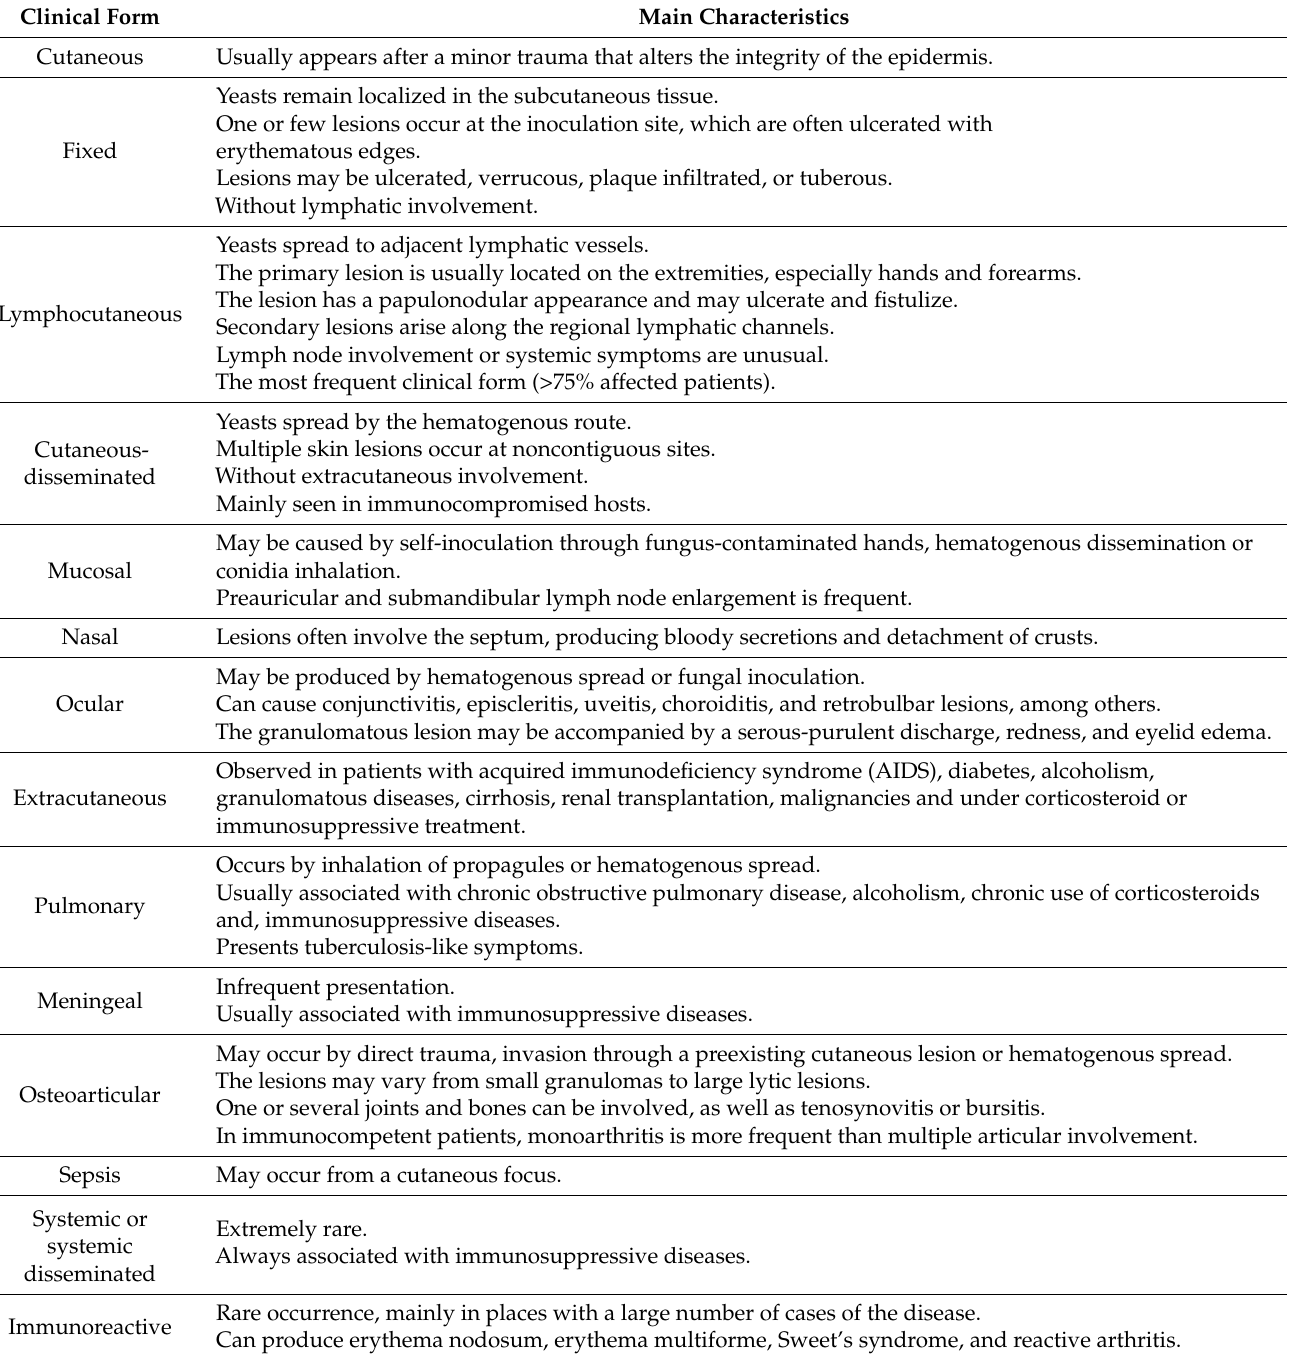
Table 4. Clinical forms of